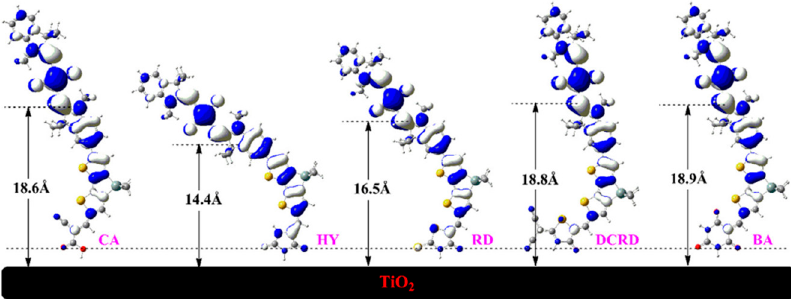
Figure 4. Illustration of molecular space stretching and distance from the electron recapture center to TiO 2 surface. Reprinted from [115], with permission from Elsevier.